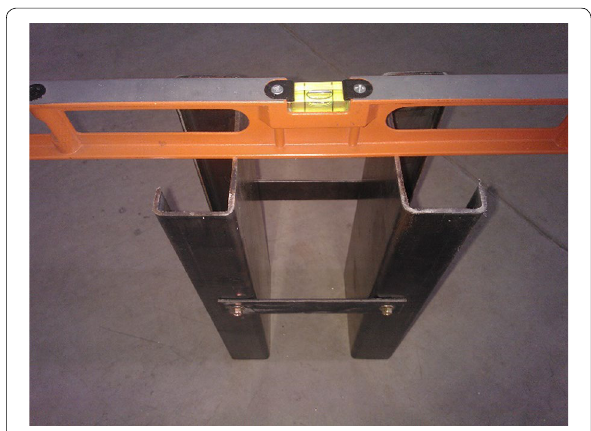
Fig. 2 Connectors